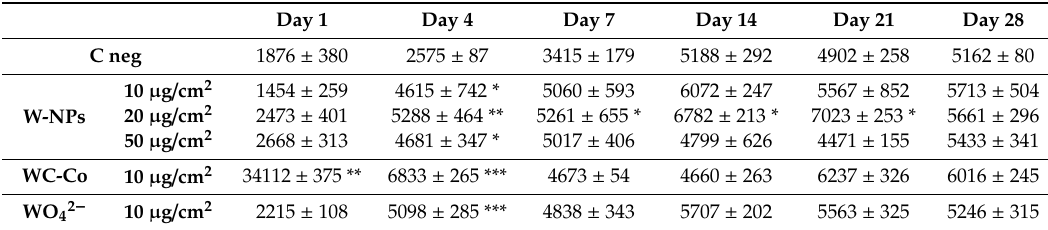
Quantification of the release of the pro-inflammatory cytokine IL-8 in MucilAir ™ basolateral